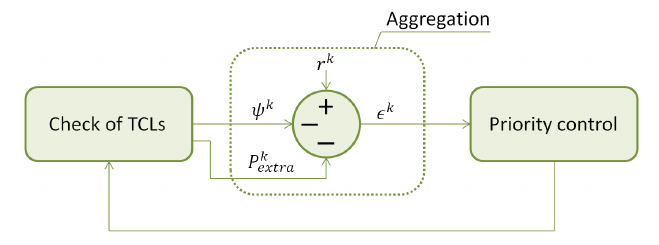
Figure 1. Structure of the virtual battery (VB)